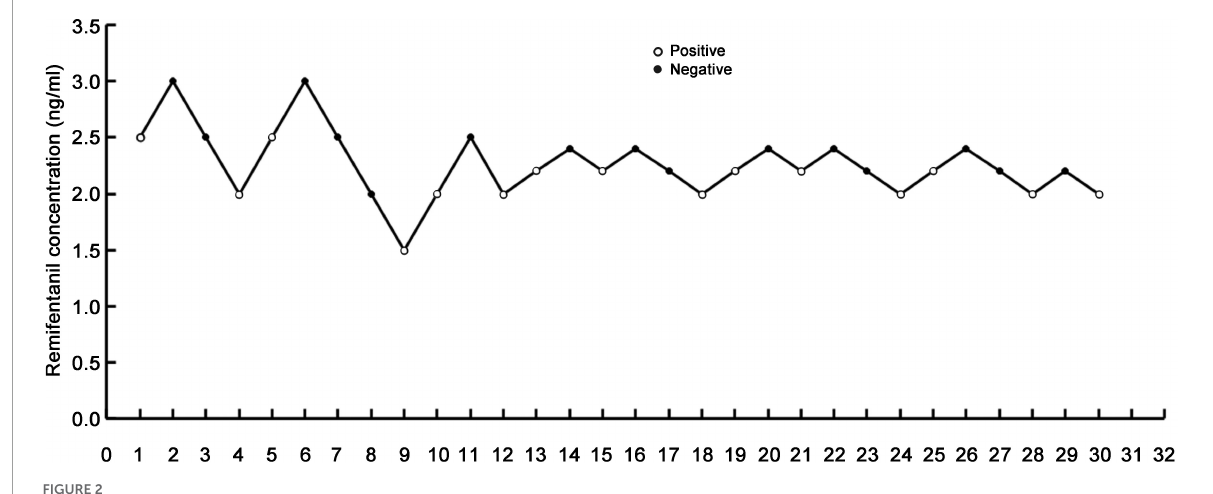
FIGURE2 Stress response of patients to fiberoptic bronchoscopy.